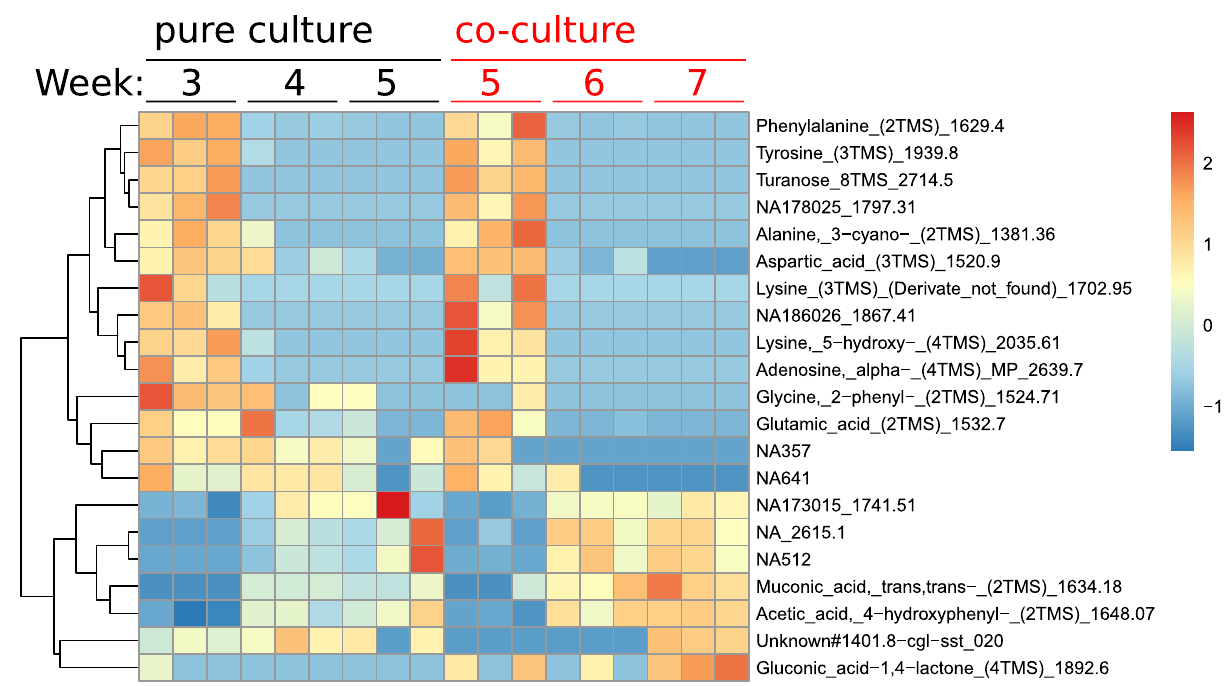
Fig. 6 Heatmap showing signi fi cantly different metabolite levels ( p < 0.05 false discovery rate, FDR corrected) between corresponding growth phases of pure culture ( Ca . Schef fl eriplasma hospitalis) and co-culture ( Ca . Micrarchaeum harzensis- Ca . Schef fl eriplasma hospitalis). Normalisation was done using a z-score, and signi fi cance was calculated by a two-tailed t -test. Source data are provided as a Source Data fi